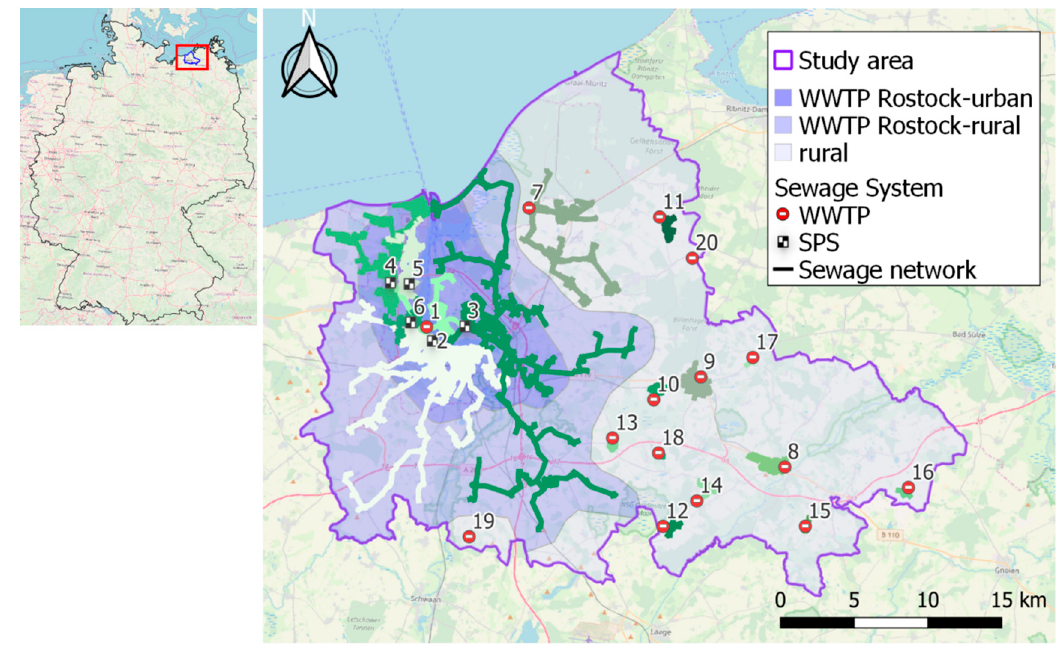
Figure 1. Location and extent of the study area: The sewage network colors indicate different catchments; from the catchments of the five largest sewage pumping stations (SPSs) (Points 2 to 6), which cover rather rural areas (light purple), as well as rather urban areas (dark purple), wastewater is transferred to the central wastewater treatment plant (WWTP) of Rostock (Point 1); background map: OpenStreetMap (OSM).